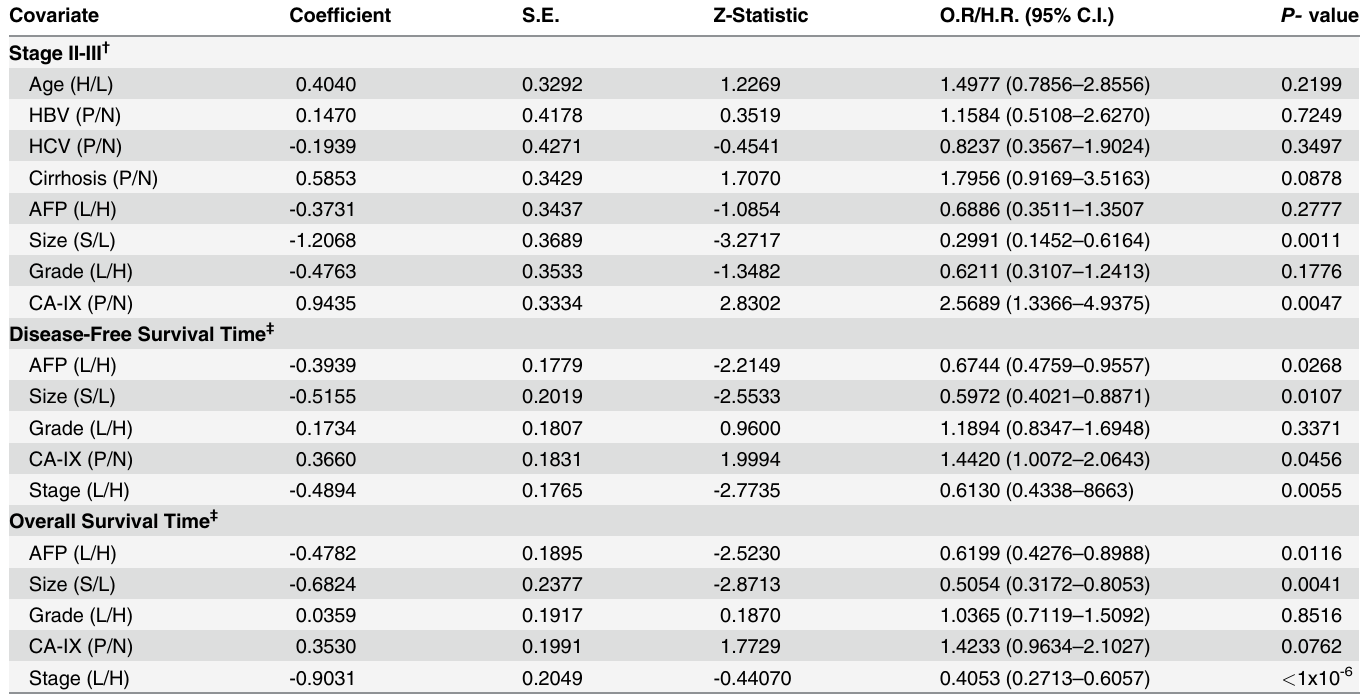
Table 2. Multivariate analyses of the risk factors associated with high stage tumor, disease-free survival and overall survival of patients with surgically resectable primary hepatocellular carcinoma. Covariate Coef fi cient S.E. Z-Statistic O.R/H.R. (95% C.I.) P-